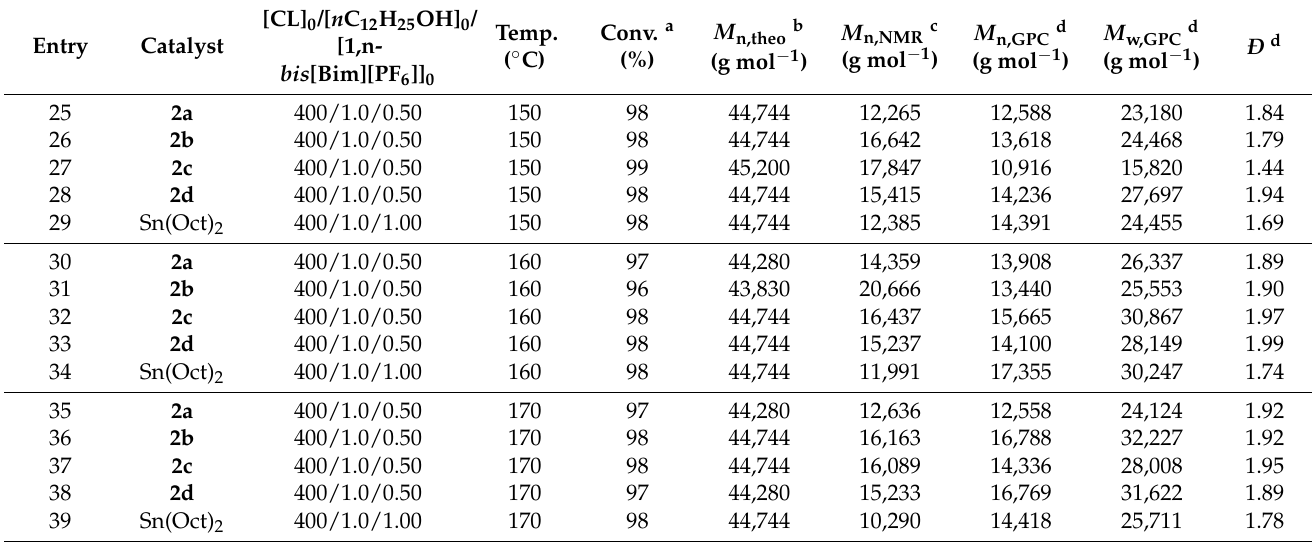
Table 2. The molecular weight averages, molecular weight distribution, and % conversion for the ROP of CL catalyzed by 2a – 2d and Sn(Oct) 2 with n C 12 H 25 OH initiator at different temperatures for 72 h.